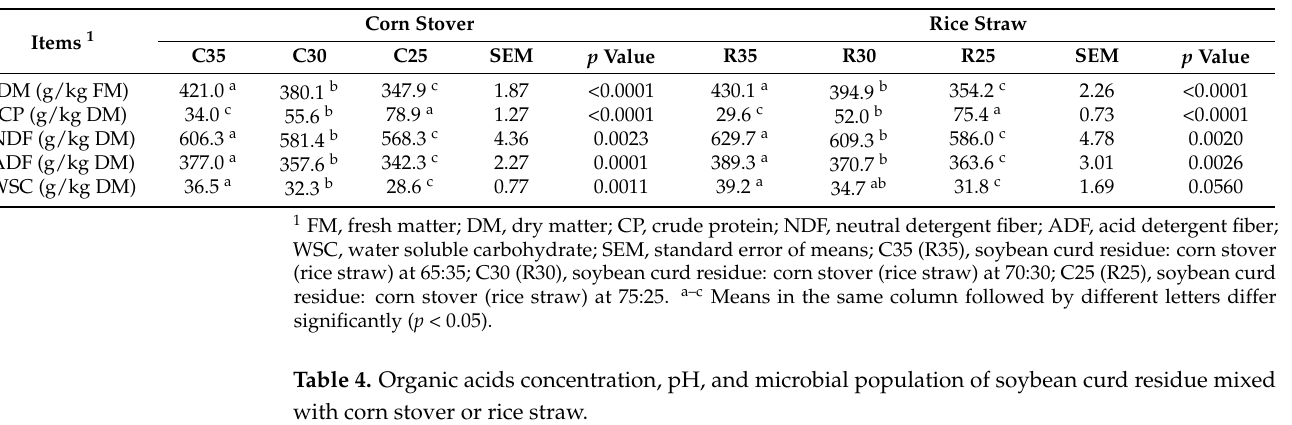
Table 3. Chemical composition of soybean curd residue mixed with corn stover or rice straw.